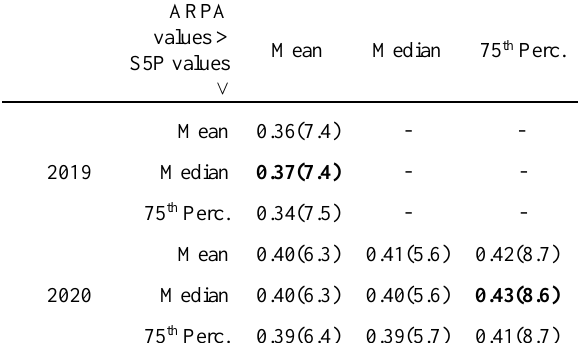
Table 4. R-squared values and RMSE values (in parenthesis) for values from ground measured aggregated to single